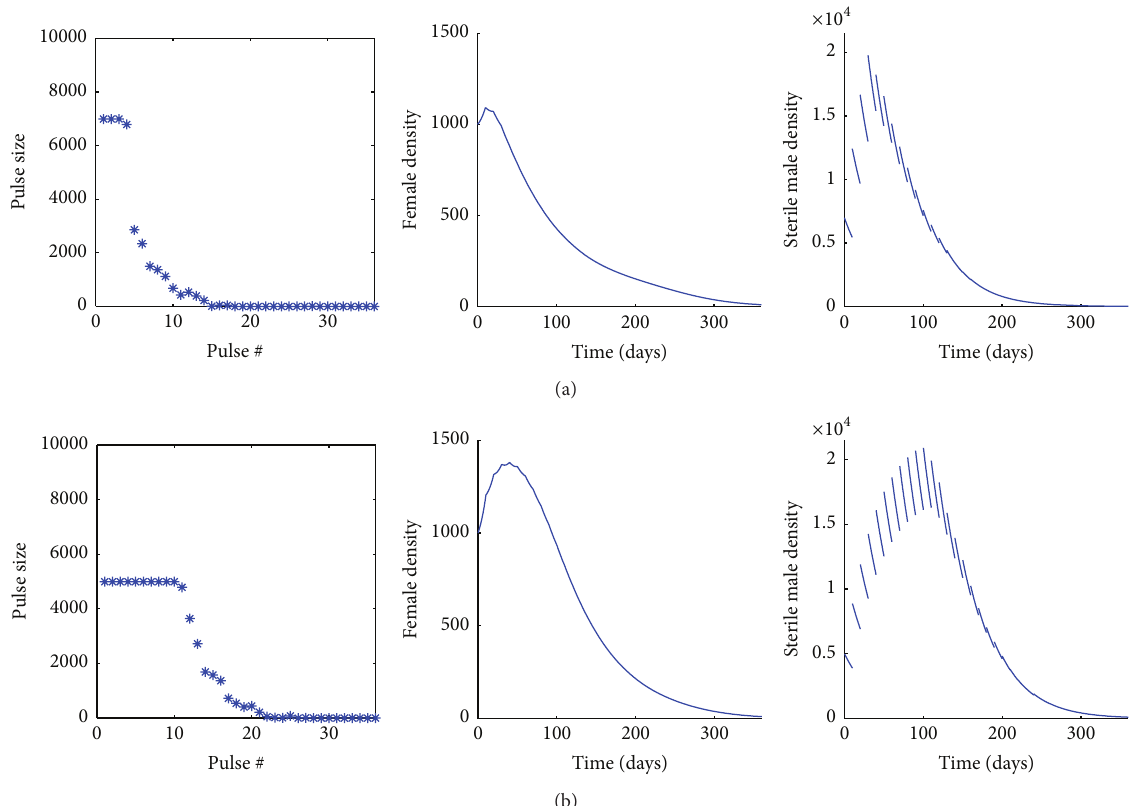
Figure 3: With interpulse time fixed to 10 days we now vary sterile release bounds to 7000 (a) and 5000 (b). Intense and prolonged sterile release is required during the first stages until the pest growth tendency is reversed. Notice that the Allee threshold takes longer to appear. Changing the problem with an interpulse time of 15 days did not produce a solution; that is, invasion is